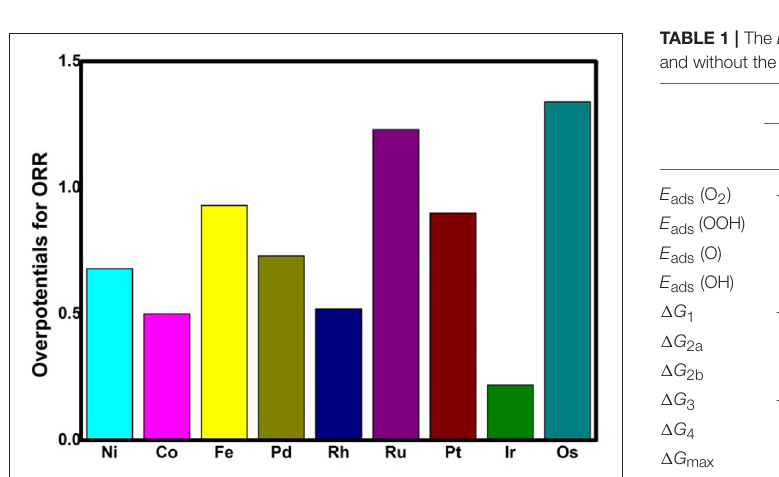
In( k 2a / k 2b ) are − 2.72, − 7.78, and − 0.39, indicating the energy favorability of R 2b compared with that of R 2a for group 10.